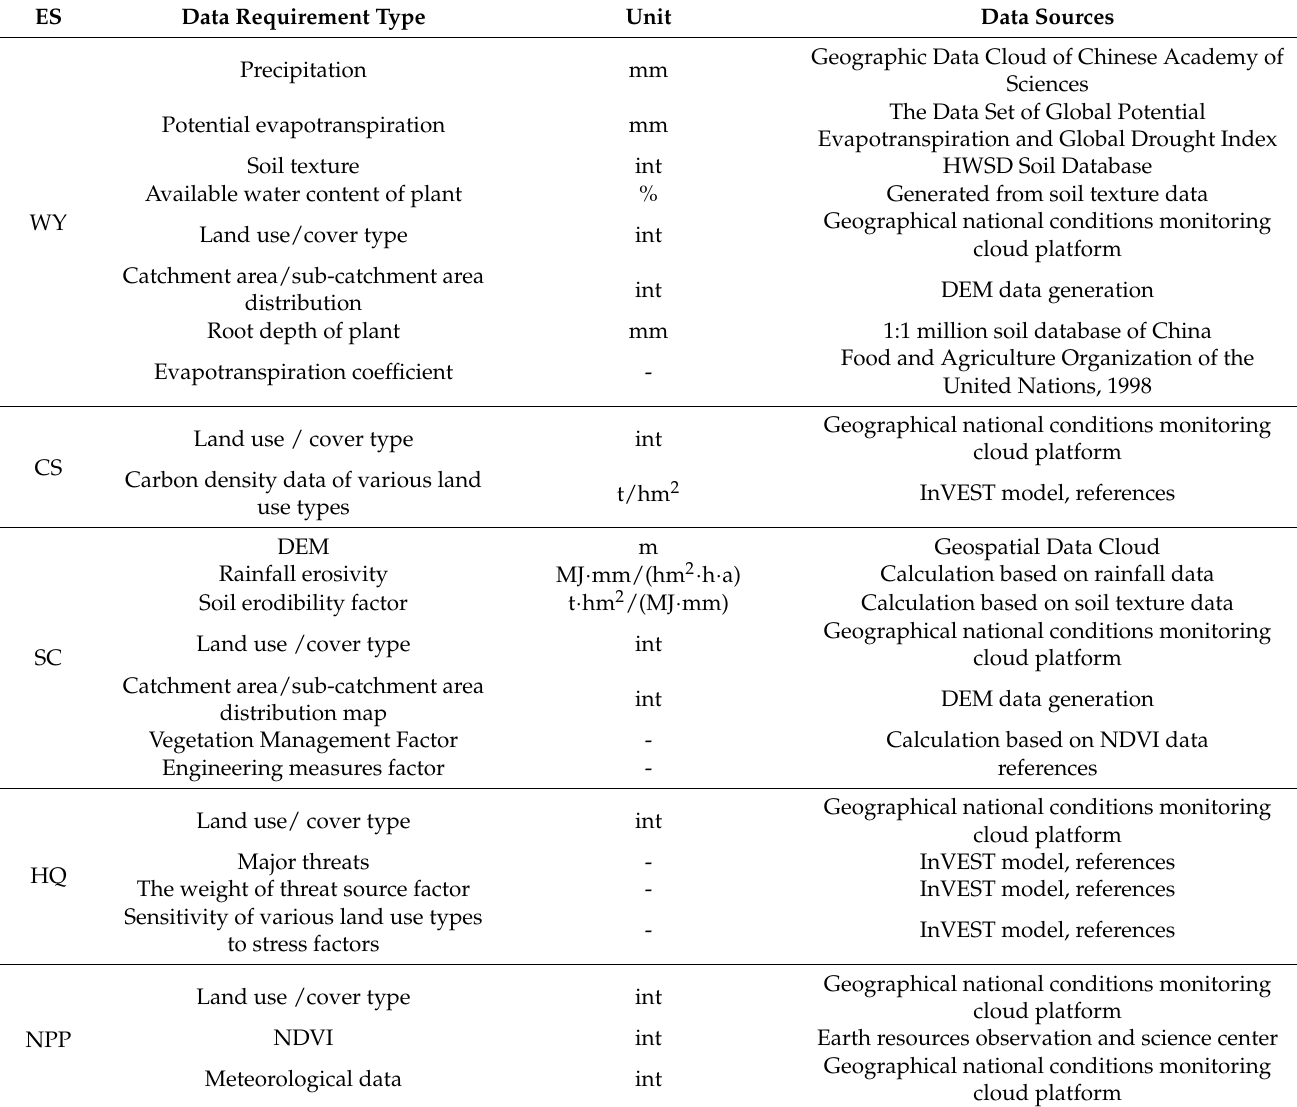
Table 1. Summary of main data types and data